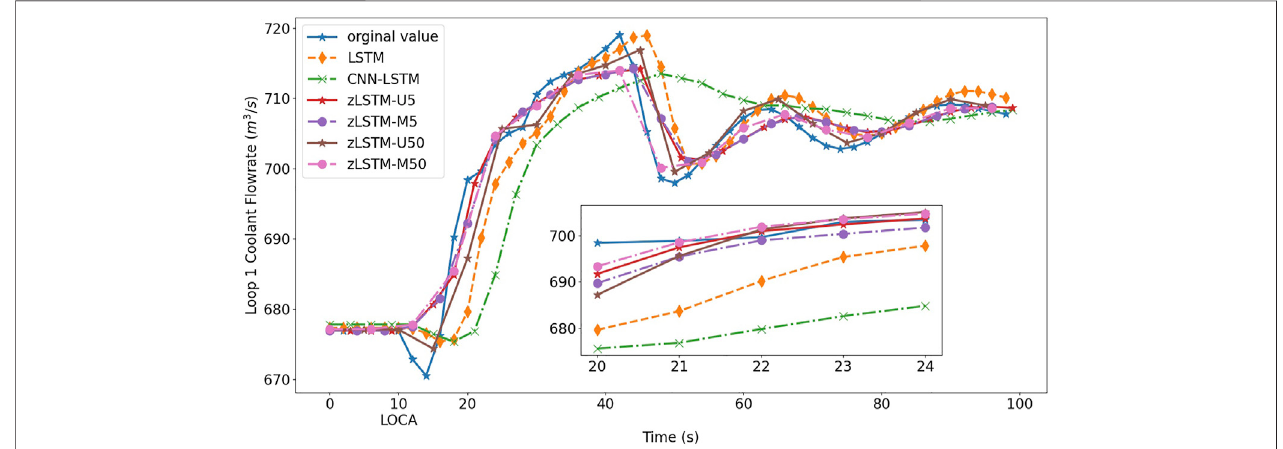
FIGURE 4 | Prediction of loop 1 coolant fl owrate on break size 0.9 cm 2